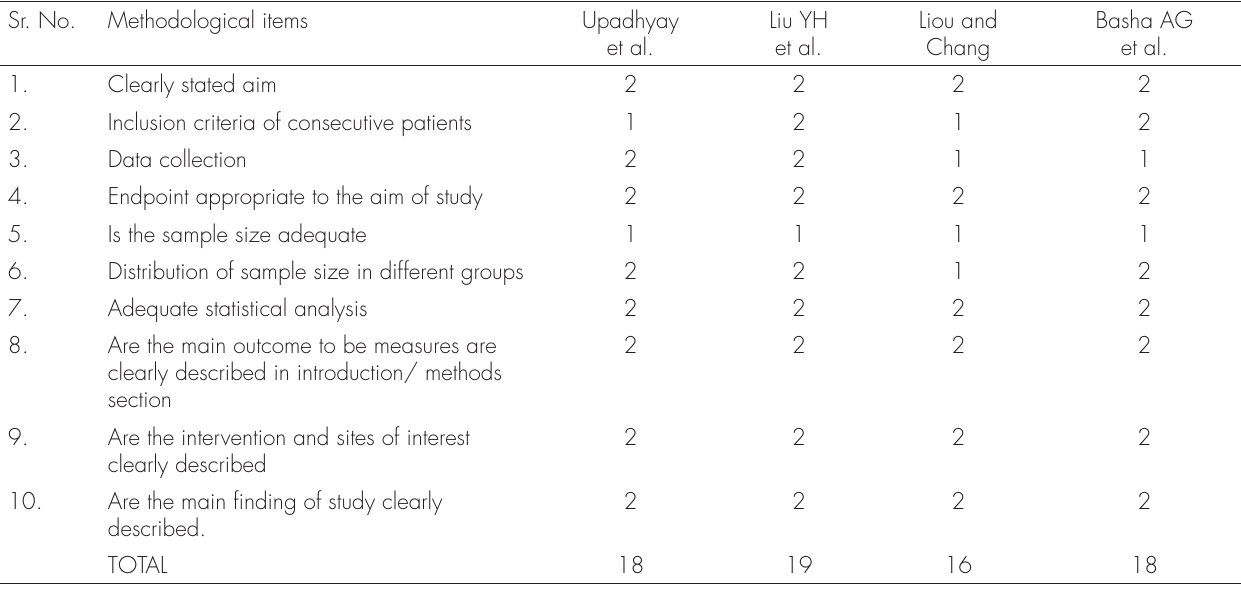
Table IV. Quality of studies when mini-implants are compared with intra oral anchorage